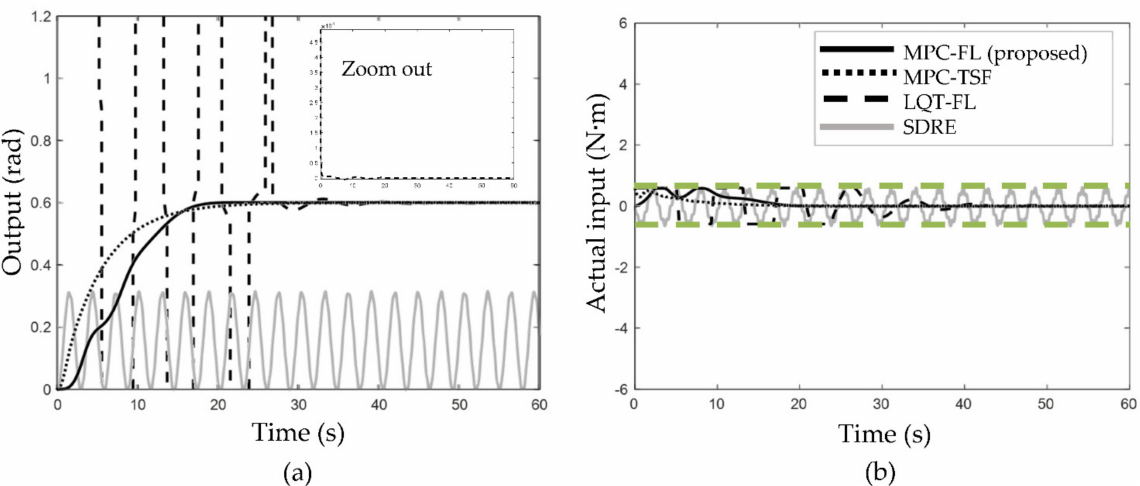
Figure 7. Flexible-joint mechanism by applying the four control schemes with input constraints ± 0.59 N · m: ( a ) output responses; ( b ) input signals.